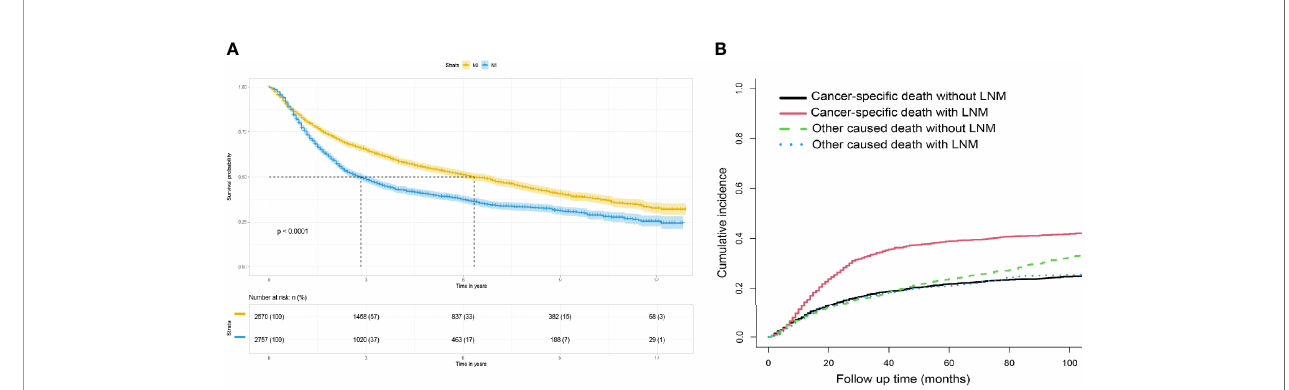
FIGURE 4 | (A) Survival analysis: Kaplan-Meier survival curves grouped according to lymph node status in the training set. (B) Competitive risk curve: death from non-bladder cancer in the training set was regarded as a competitive risk event.